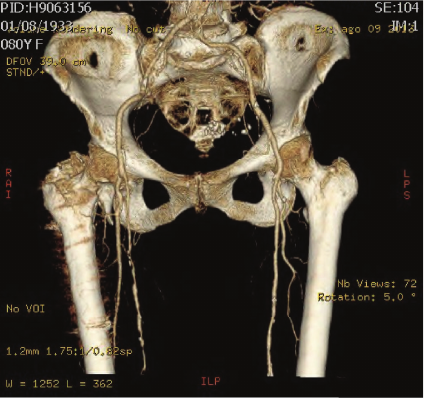
Figure 4: The angio-CT scan demonstrates proximal migration of the lesser trochanter in the femoral triangle of Scarpa without neurovascular